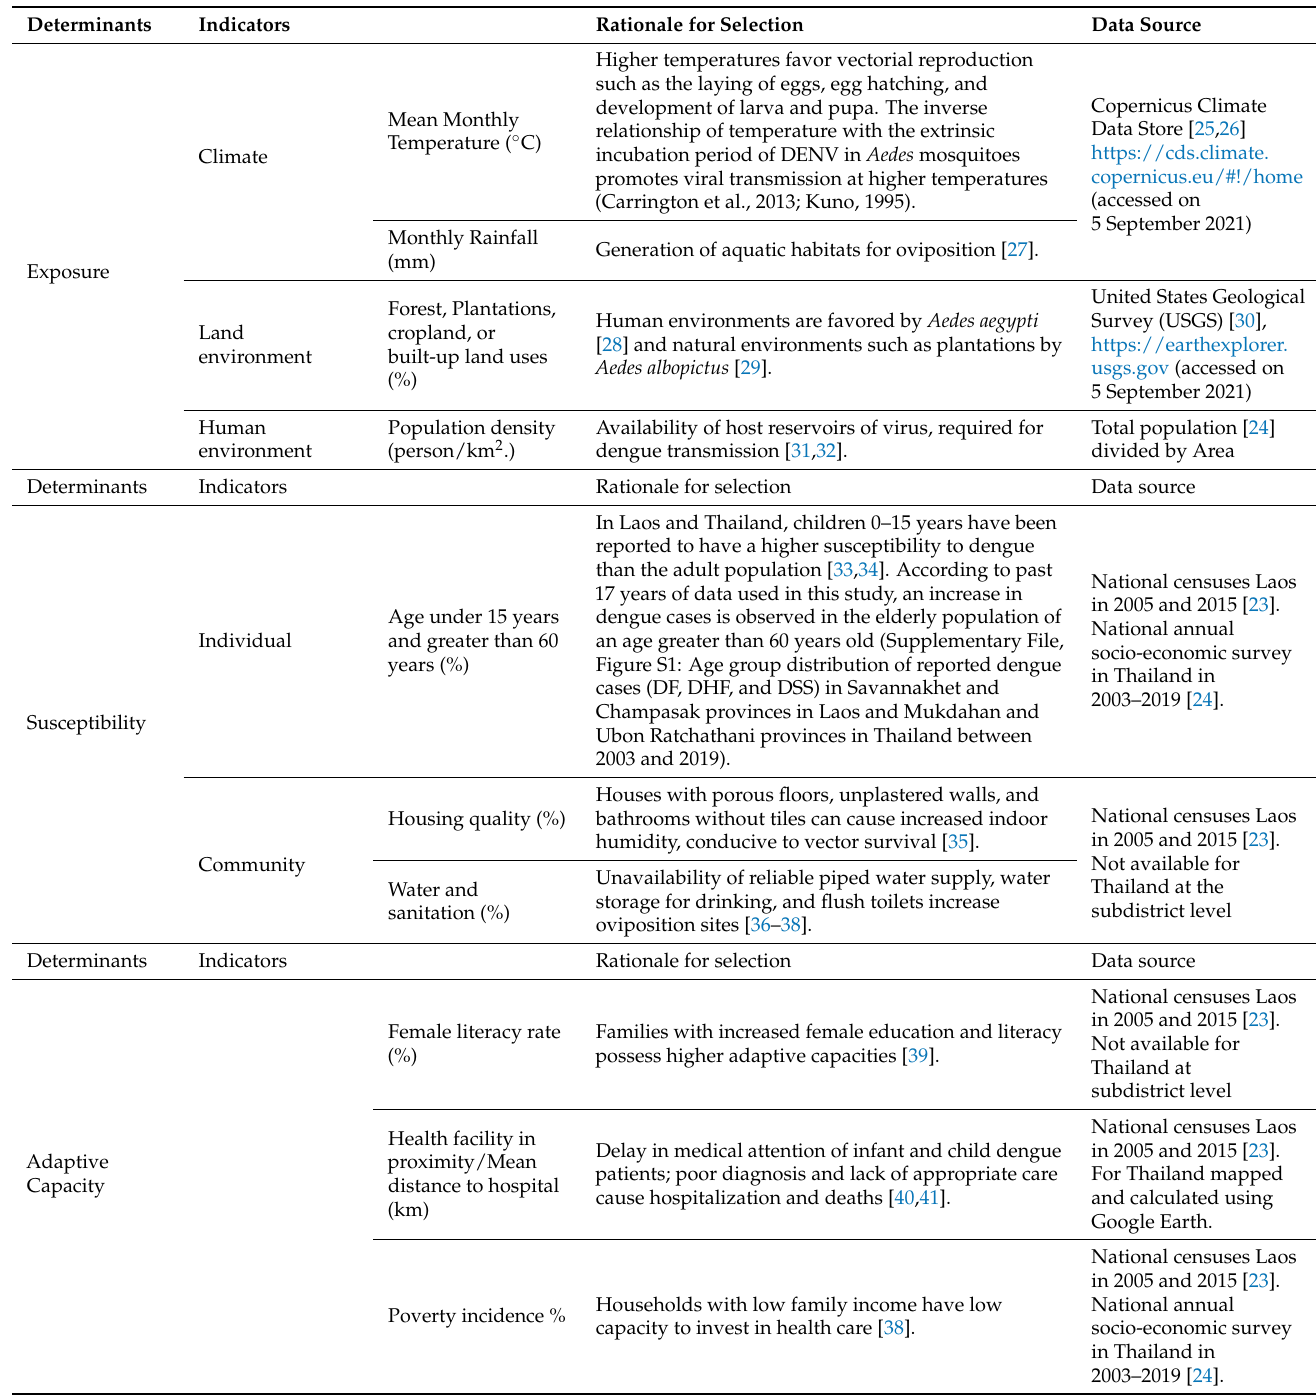
Table 1. Determinants, indicators, and rationale for selection of data and their sources for vulnerability assessment. Determinants